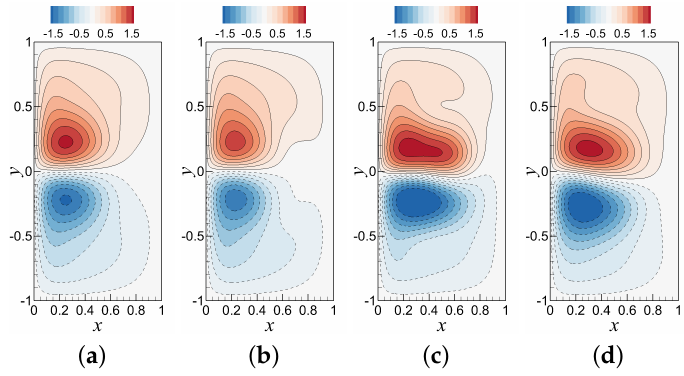
Figure 10. Mean stream function contour plots between t = 15 and t = 60 obtained by reference FOM and different ROM simulations for Re = 25 and R = 10 modes: ( a ) ψ FOM at a resolution of 128 × 256; ( b ) ψ ROM-GP ; ( c ) ψ ROM-ANN ; and ( d ) ψ ROM-H . This figure clearly illustrates that all models have captured the two-gyre circulation pattern successfully.